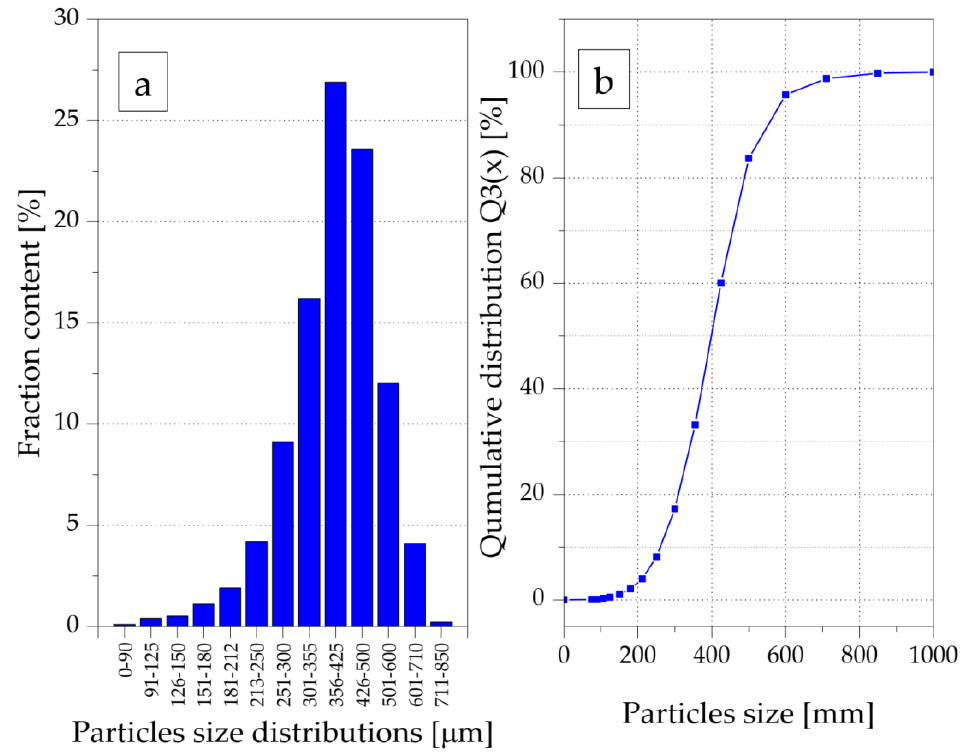
Figure 2. GTR filler size distribution obtained by CAMSIZER ® P4 (Retsch, Haan, Germany): histo- gram ( a ), qumulative curve ( b ).